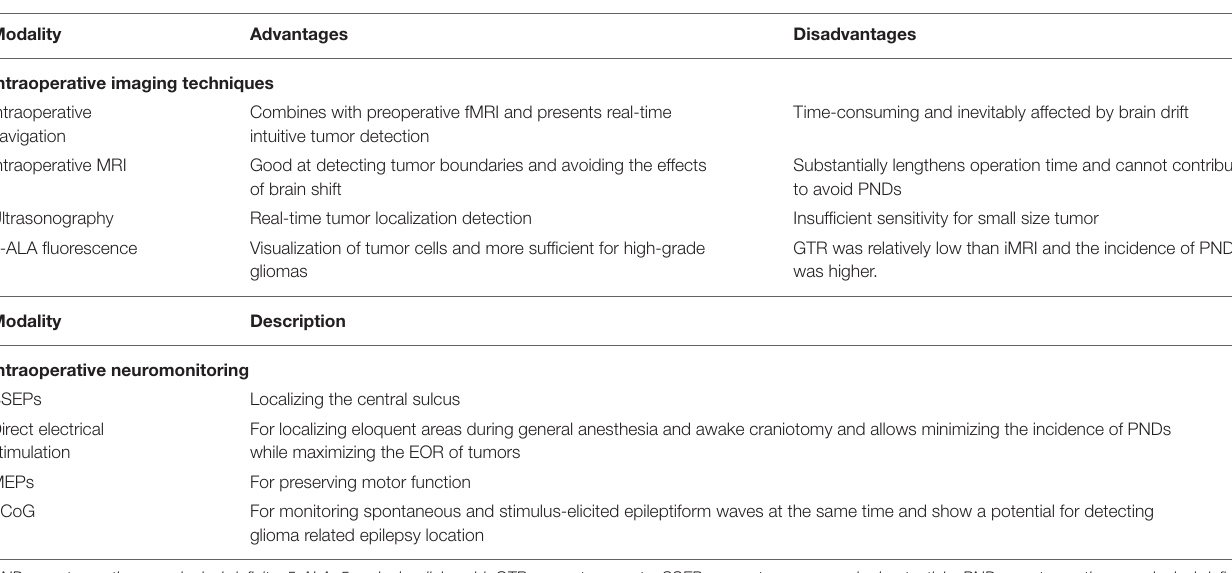
TABLE 1 | Brief description of intraoperative imaging and neuromonitoring